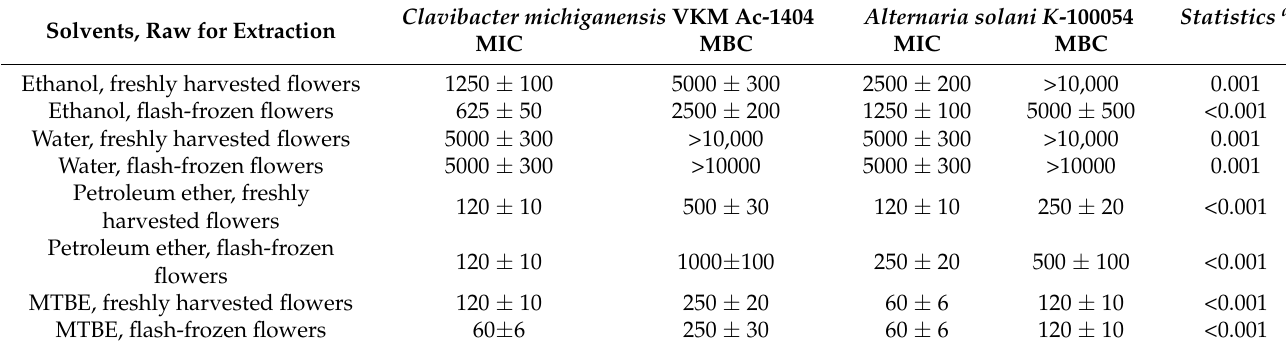
Table 4. Antimicrobial activity of extracts produced from freshly harvested and flash-frozen Centaurea scabiosa L. flowers extracted by various solvents ( µ